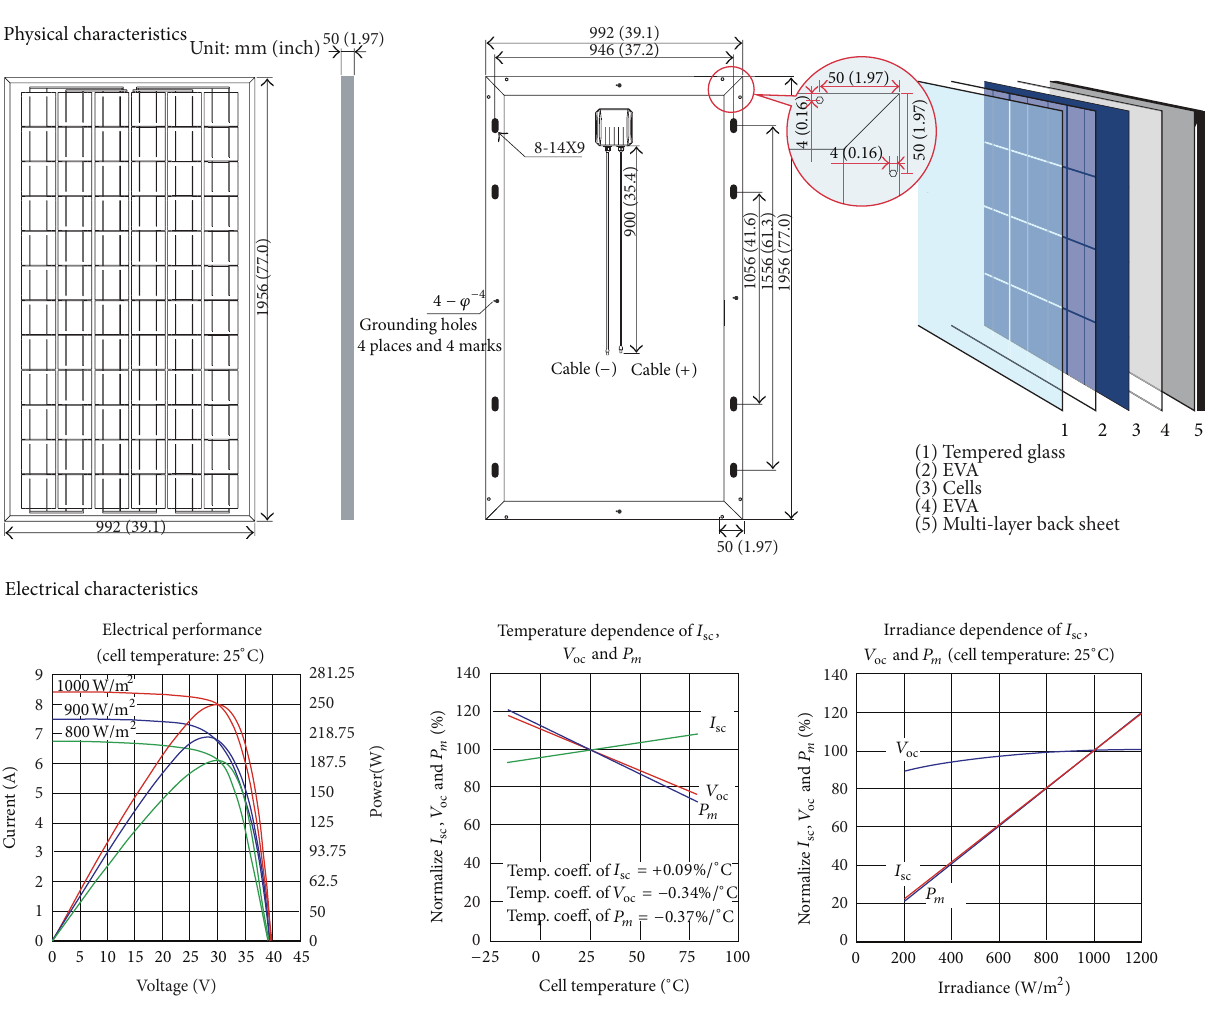
Figure 2: Specifications of the panels